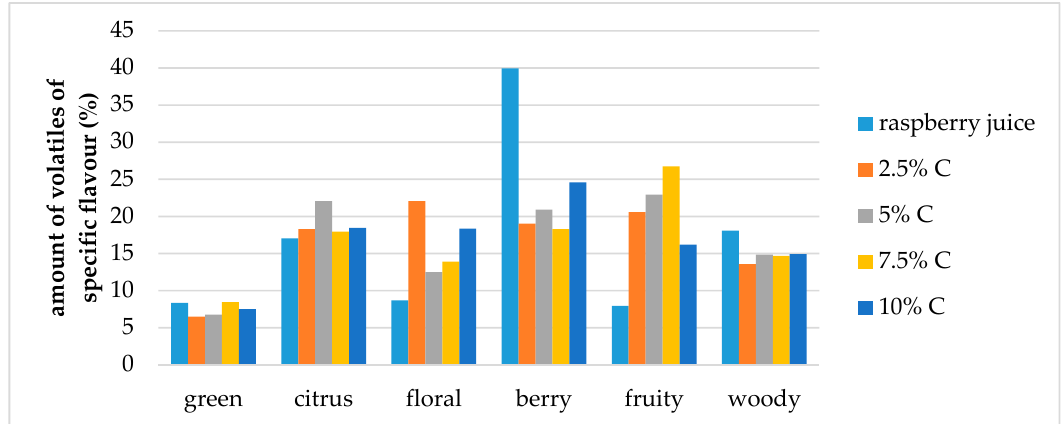
Figure 8. Amount of volatiles of specific flavor profile of raspberry juice and cellulose/raspberry complexes prepared by 60 min complexation (C—cellulose) after storage.